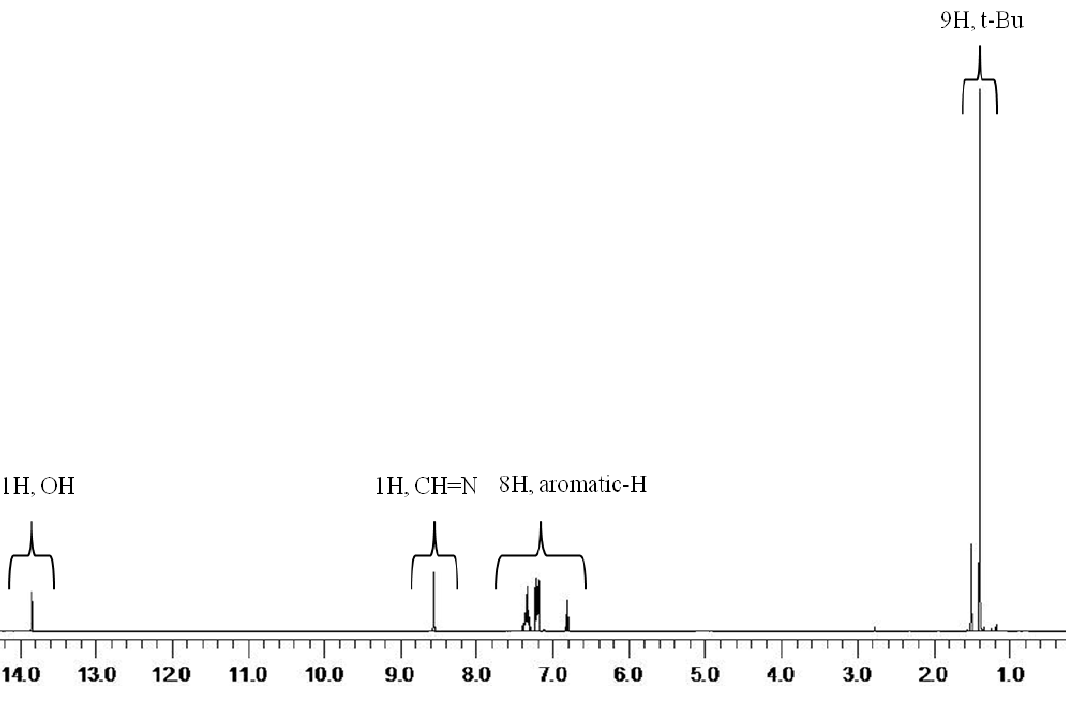
Figure 1. 1 H-NMR of N -(3- tert- butylsalicylidene) aniline or phenoxyimine